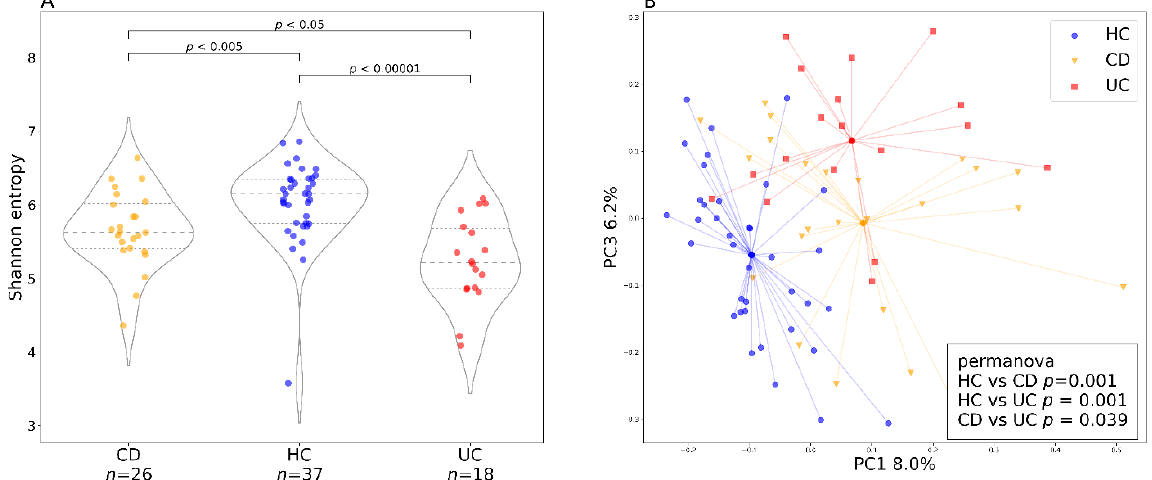
Figure 2. Baseline bacterial alpha and beta diversity for the two IBD groups and healthy controls. ( A ) baseline (week 0) bacterial alpha diversity represented by Shannon entropy plotted for Crohn’s disease and ulcerative colitis as well as healthy controls. In the violin plots, the middle dashed line represents the median and the outer dashed lines represent the first and third quartiles. ( B ) PCoA plot shows the bacterial beta diversity represented by the Bray–Curtis metric for the three groups (Crohn’s disease, ulcerative colitis, and healthy controls) at baseline (week 0). The dots represent samples at baseline and the lines are connecting individual samples with cluster centroids. The box in the lower right corner shows the results of the PERMANOVA test with 999 permutations. Abbreviations: CD, Crohn’s disease; HC, healthy controls; UC, ulcerative colitis; n , number of